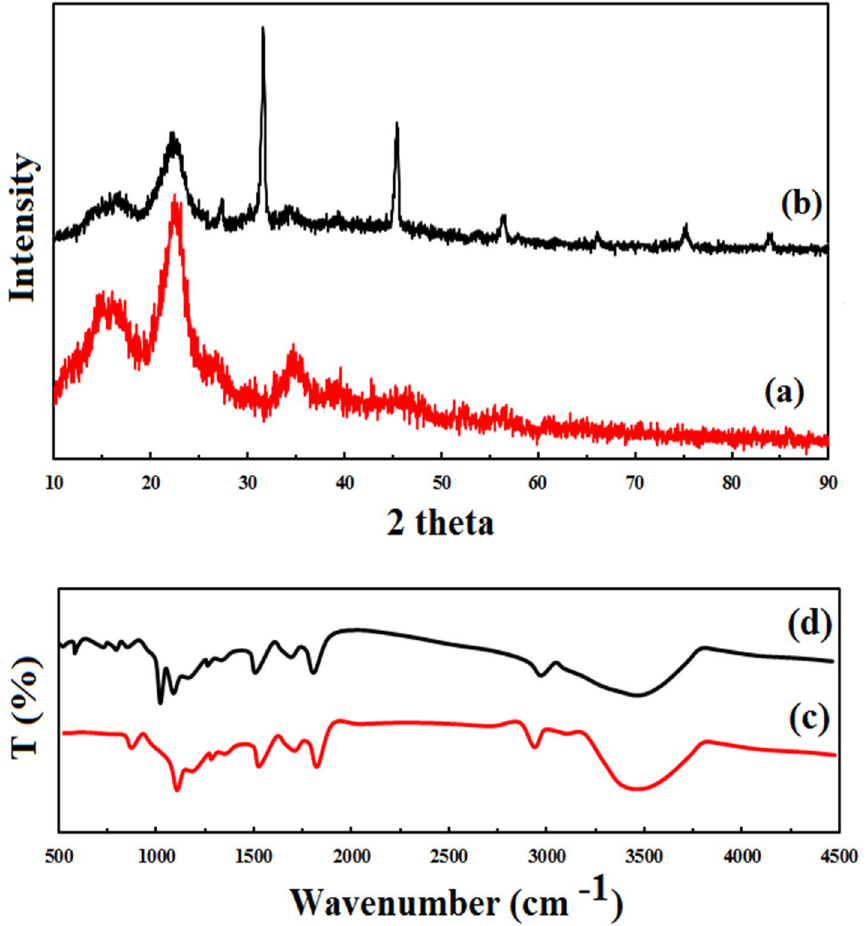
Figure 6. XRD and FTIR of raw lignocellulosic sawdust ( a , c ) and lignocellulosic sawdust-Fe/Zn composite ( b , d